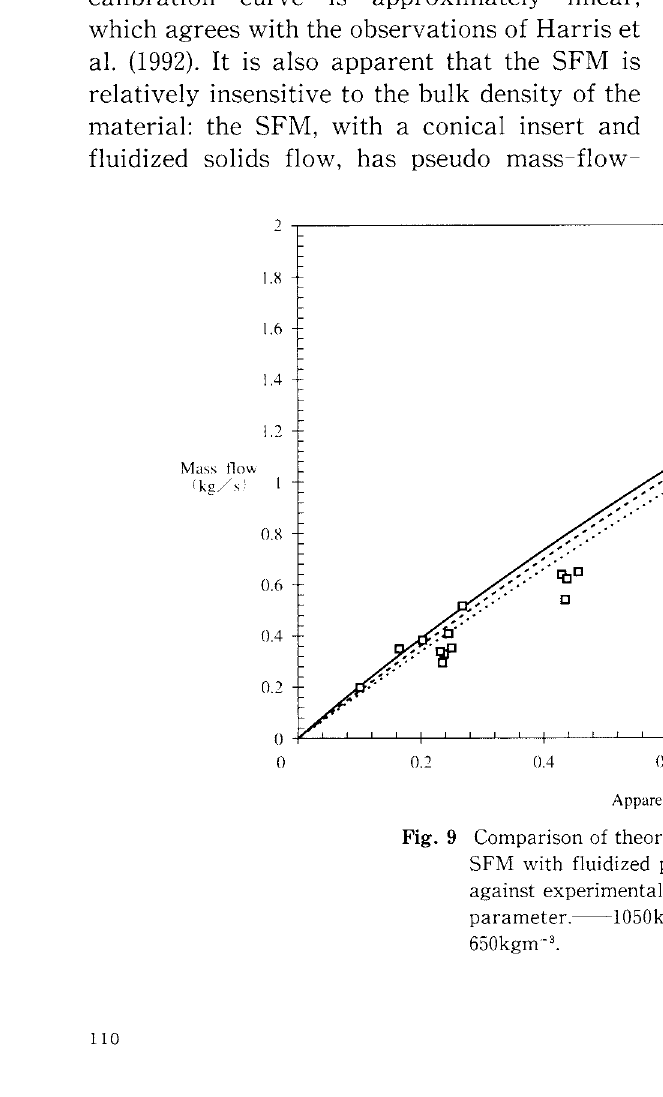
Fig. 9 Comparison of theoretical calibration for pilot scale SFM with fluidized particles (equations (13) & (14)) against experimental data ( CJ ), with bulk density